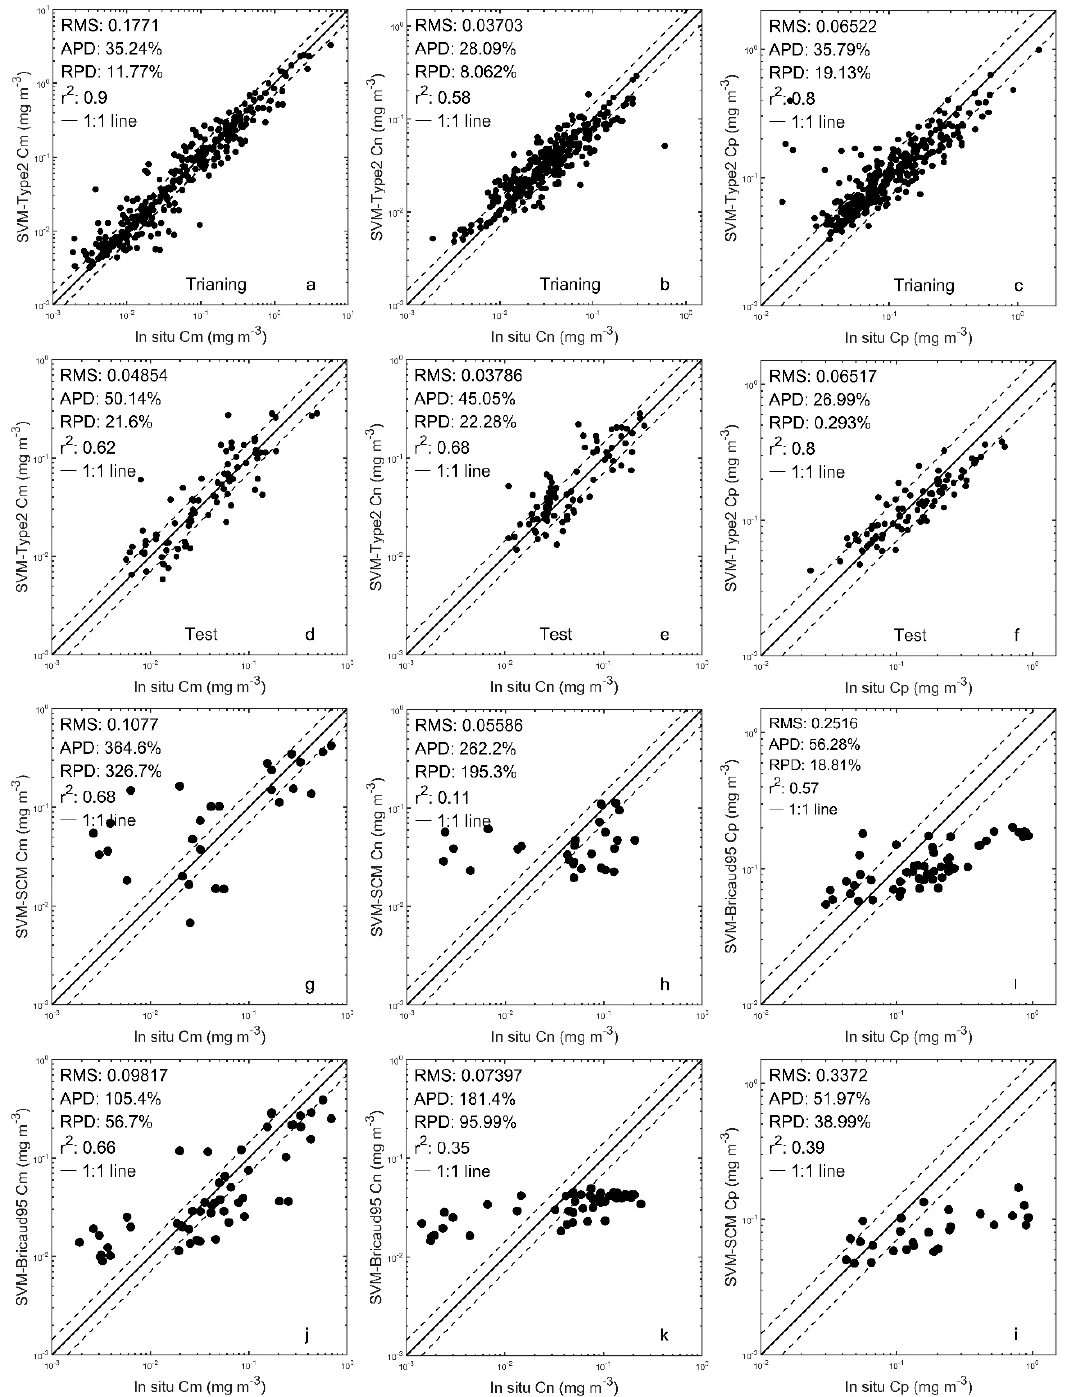
Figure 7. Scatter plots of the PSC derived from the model against in situ PSC. ( a , b , c ) The scatter plots of the training dataset. (d , e , f) The scatter plots of the test dataset. ( g , h , i ) The scatter plots of SVM-SCM applied to the NESCS dataset. ( j , k , l ) The scatter plots of SVM-Bricaud95 applied to the NESCS dataset. The black line represents the 1:1 line and dotted lines represent the 1:1 line ± 30% log 10 PSC.